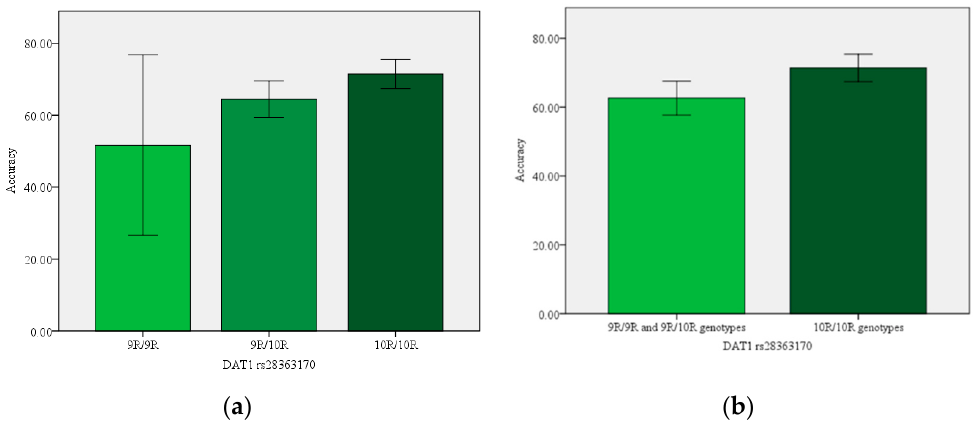
Figure 2. Effects of DAT1 rs28363170 polymorphism on acquisition accuracy of probabilistic contin- gencies during PST for AB, CD and EF conditions in HC participants: ( a ) with respect to 9R/9R, 9R/10R and 10R/10R genotypes; ( b ) with respect to 9R allele carriers (9R/9R and 9R/10R genotypes) and 10R/10R genotypes.